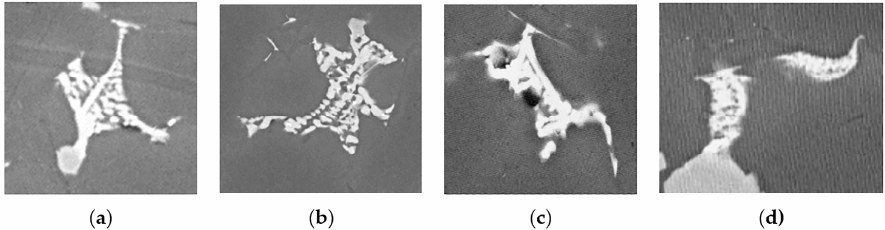
Figure 14. Line EDS analysis of Cu inter-metallic—SB 55 with v max = 4 m.s − 1 .